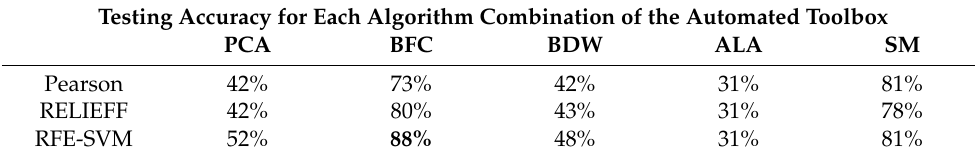
Table 4. Overview of the testing accuracies of all 15 combinations of the automated toolbox, derived in a previous study [36]. The highest testing accuracy is shown in bold.